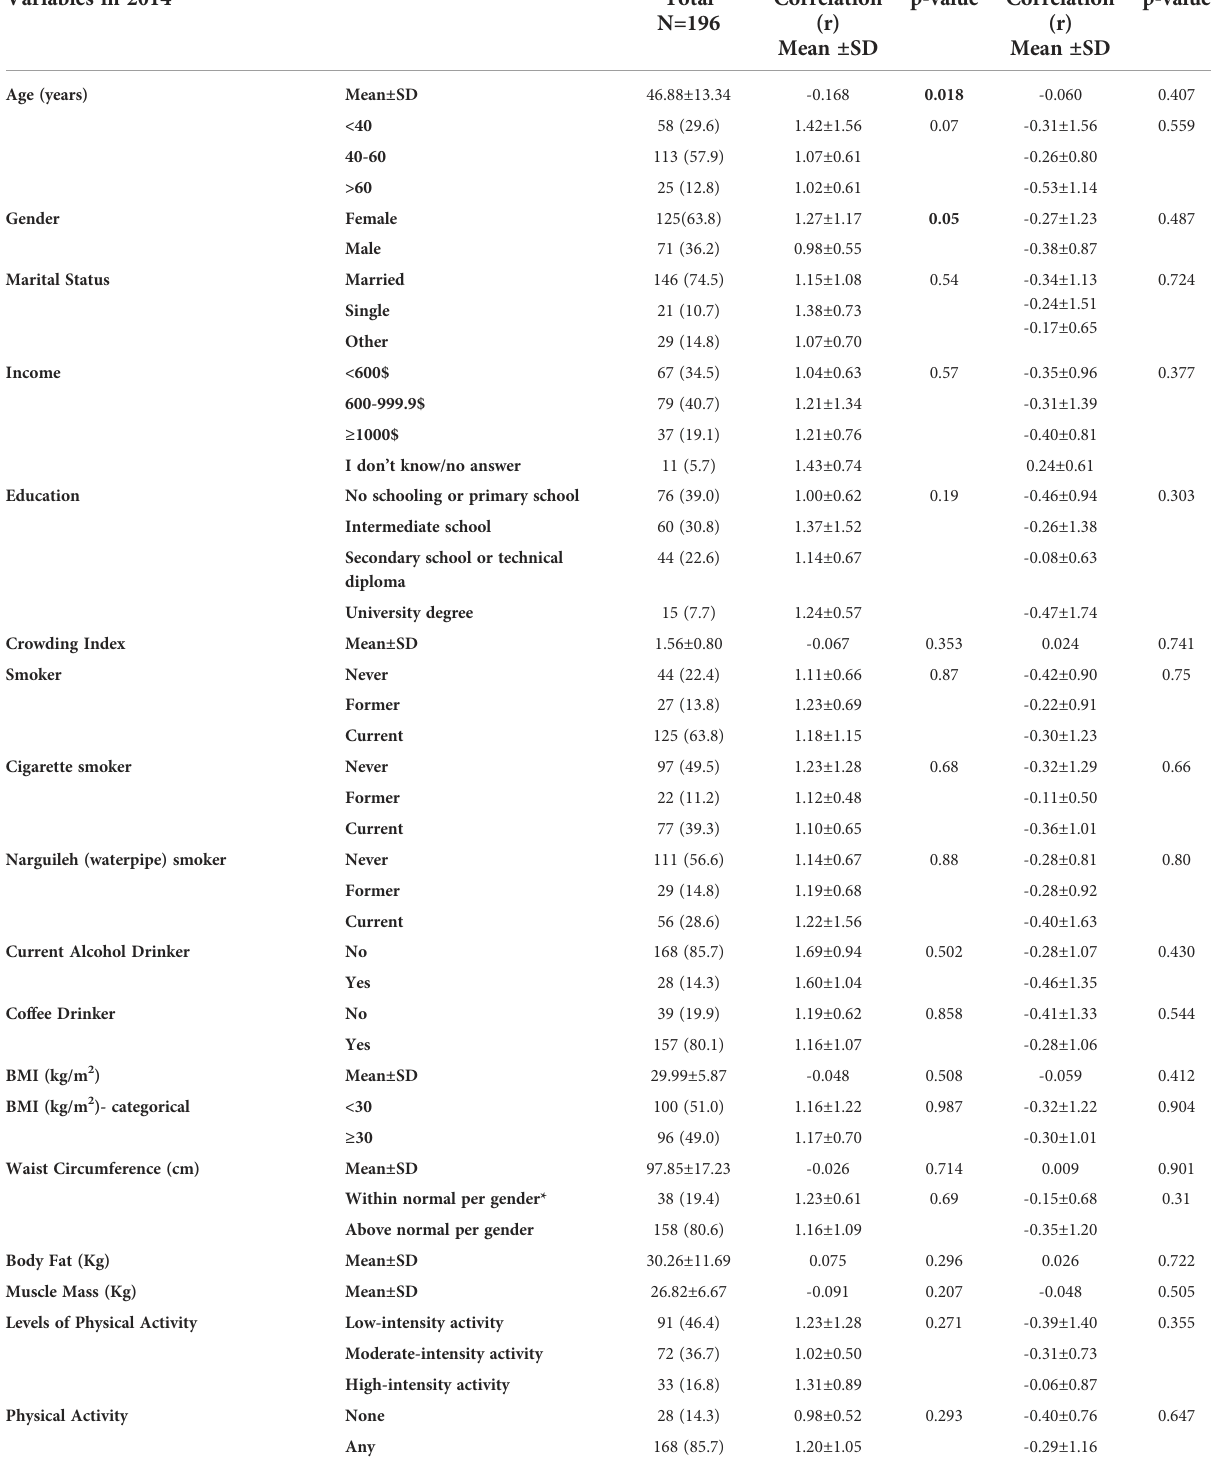
TABLE 1 Description and association of baseline characteristics and lifestyle at initial recruitment in 2014 with RTL at follow up in 2019 and D